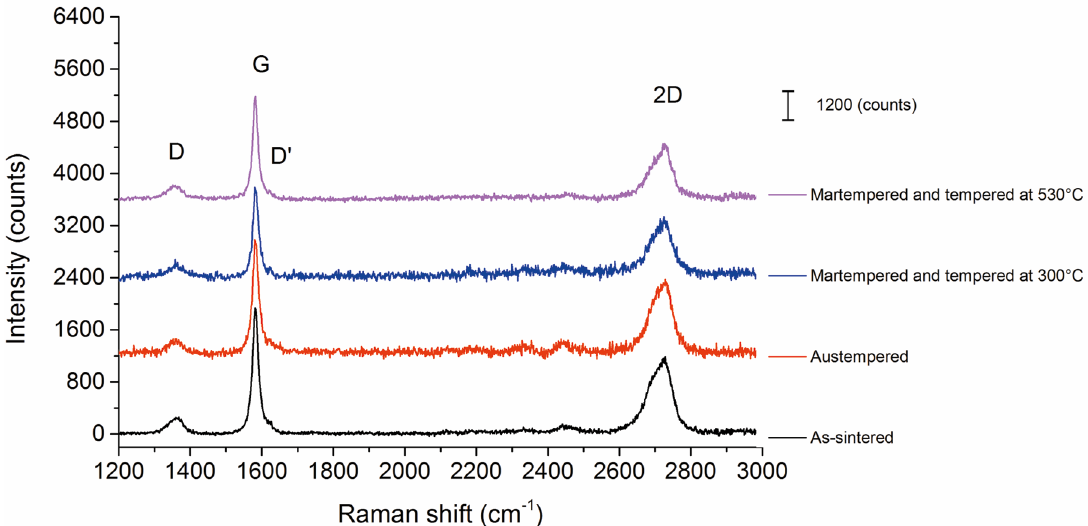
SiC in the as-sintered and heat-treated wt